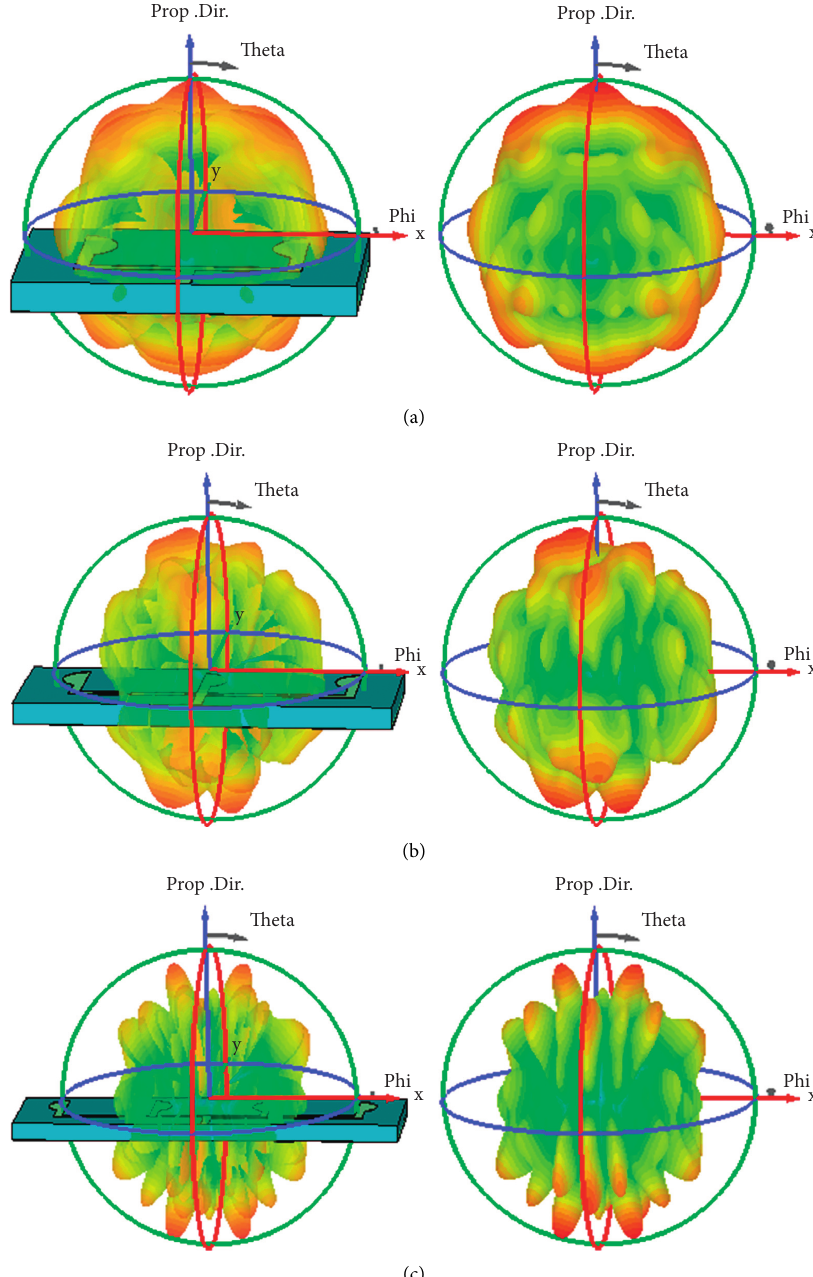
Figure 16: 3 Radiation with and without structure of (a) Array 2, (b) Array 3, and (c) Array